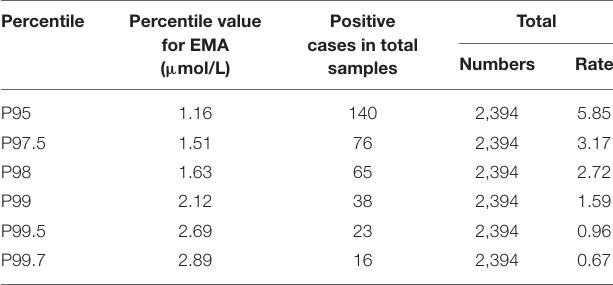
TABLE 3 | The positive rates of different percentile cut-offs with EMA by second-tier test. Percentile